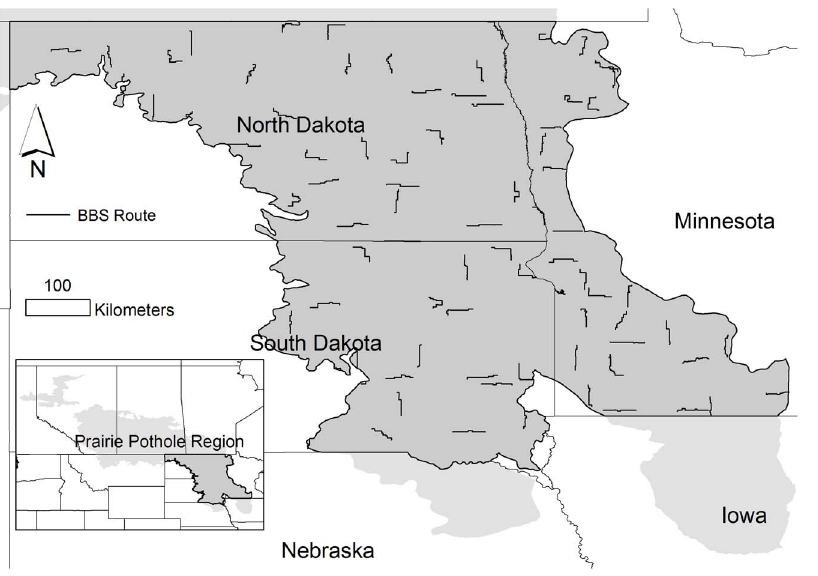
Figure 1. Bird occurrence data were obtained from 77 Breeding Bird Survey (BBS) routes throughout the Prairie Pothole Region (PPR) of North Dakota, South Dakota, and Minnesota. Climate-based projections were also made to the PPR of Iowa.